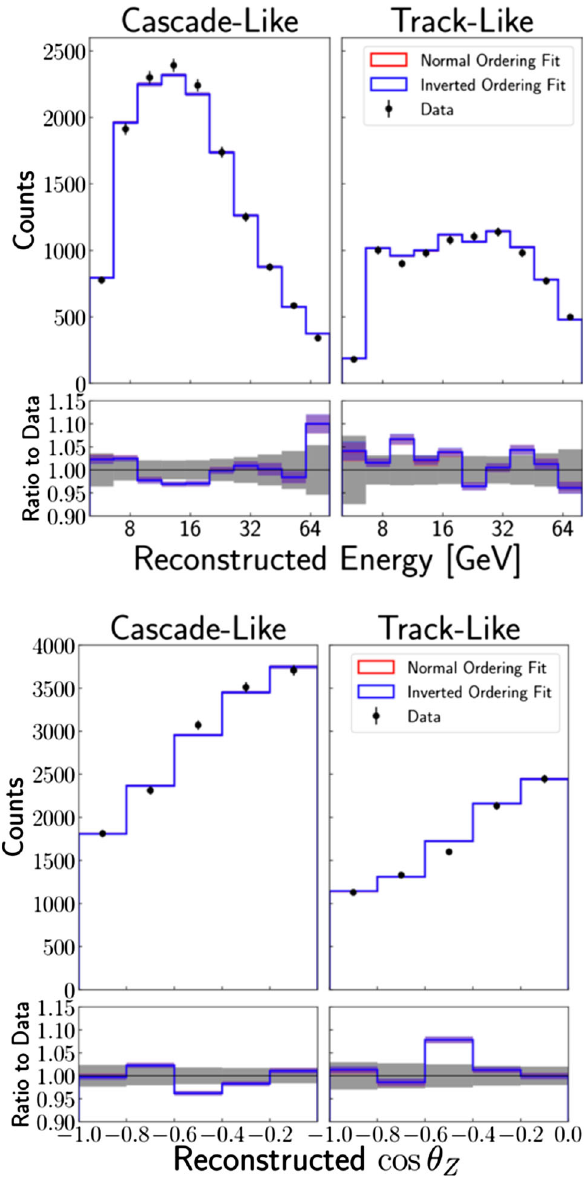
Fig. 9 Theenergyandzenith-angledistributionsofthedatafromAnal- ysis B .Alsoshownarethebest-fitsimulationsforbothorderings,where the red and blue lines fall almost on top of each other